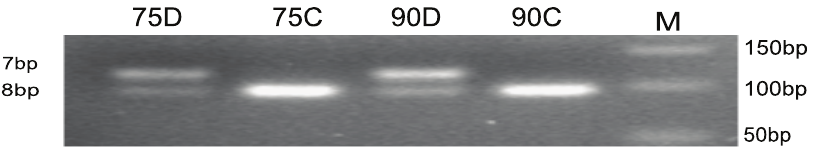
Figure 3. Biallelic status of the NNAT gene. PCR products from the genomic DNA (D) and cDNA (C) were digested with Hin f- I. Lanes from left to right are as follows: DNA on day75 of gestation, cDNA on day75 of gestation, DNA on day90 of gestation, cDNA on day90 of gestation, and the DL2000 marker.